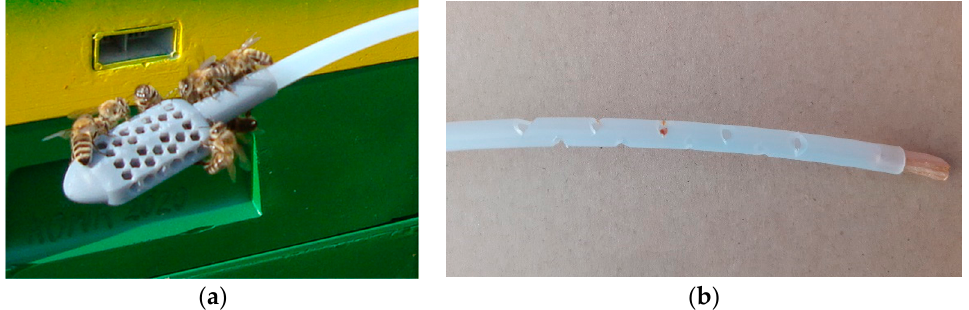
Figure 7. Sample probes used in our studies: ( a ) probe made in advance by 3D printing; the thickness of the probe is greater than the gas line diameter (6/4 mm); ( b ) probe invented and made in field conditions. The gas line was cut with small holes, close to its end. The probe has the diameter of the gas line.